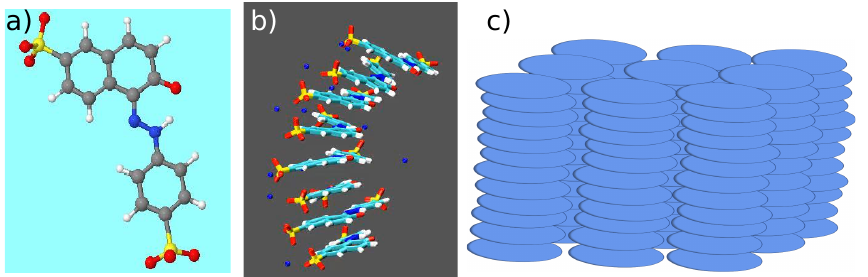
Figure 7. ( a ) The disc-shaped structure of the chromonic dianionic monoazo food dye sunset yellow in the NH hydrazone tautomer (the stable tautomeric form in aqueous solution); ( b ) stacking of sunset yellow molecules in solution into a chromonic aggregate (blue spheres represent sodium counterions) as seen in molecular dynamics simulations of sunset yellow [106]; ( c ) schematic diagram showing typical alignment of chromonic aggregates to form a liquid crystalline phase.